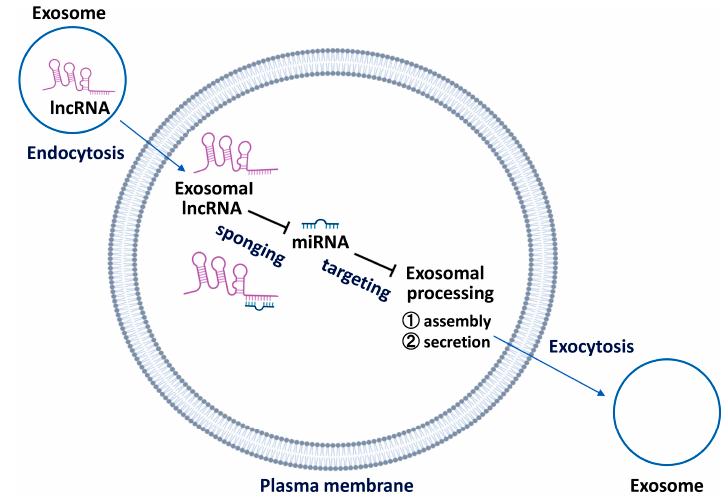
Figure 1. Overview of the objectives of this review. The lncRNA–miRNAs–exosomal processing targets axis is shown. It starts from exosomal lncRNAs sponging miRNAs that target exosomal processing (including (1) assembly and (2) secretion) genes. For clarification, the detailed components of exosomes are not shown, and only the lncRNAs and miRNAs are indicated.